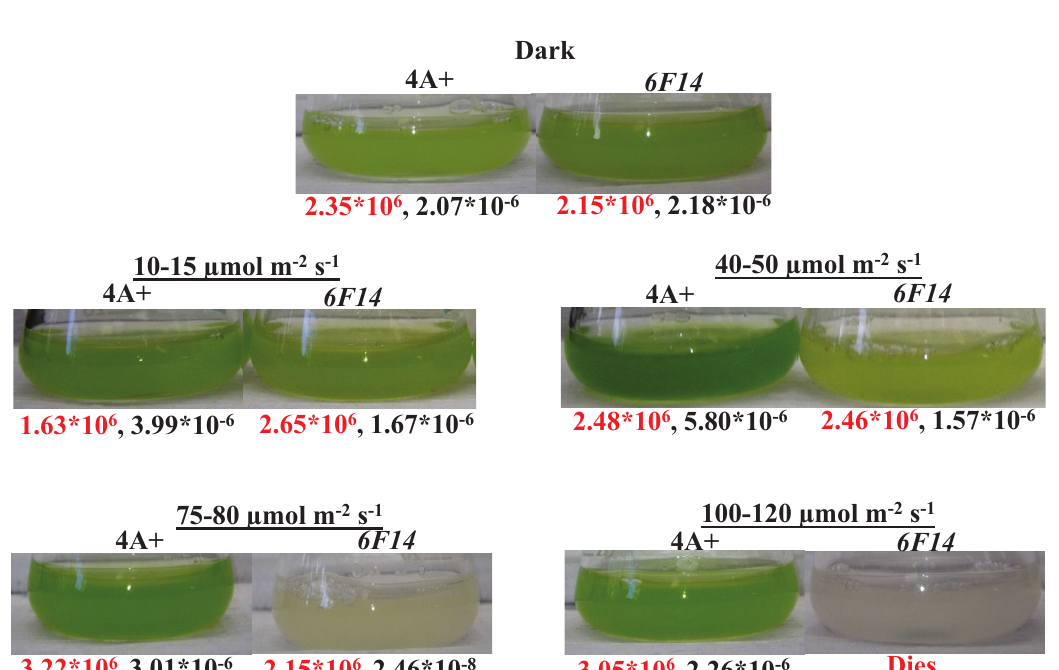
Figure 4. Heterotrophic and mixotrophic growth of 6F14 and the wild-type in TAP media. Dark adapted cells of 6F14 and 4A+ were shifted to different light intensities in this experiment. Light conditions and strains are labeled above the culture flasks. The cell density (cells/ml) and nmol chlorophyll (Chl) per cell are shown below the culture flasks in red and black numbers, respectively. For each light condition, experiments were performed on three biological replicates of each strain. Statistical error (±SD) was ≤ 10%.